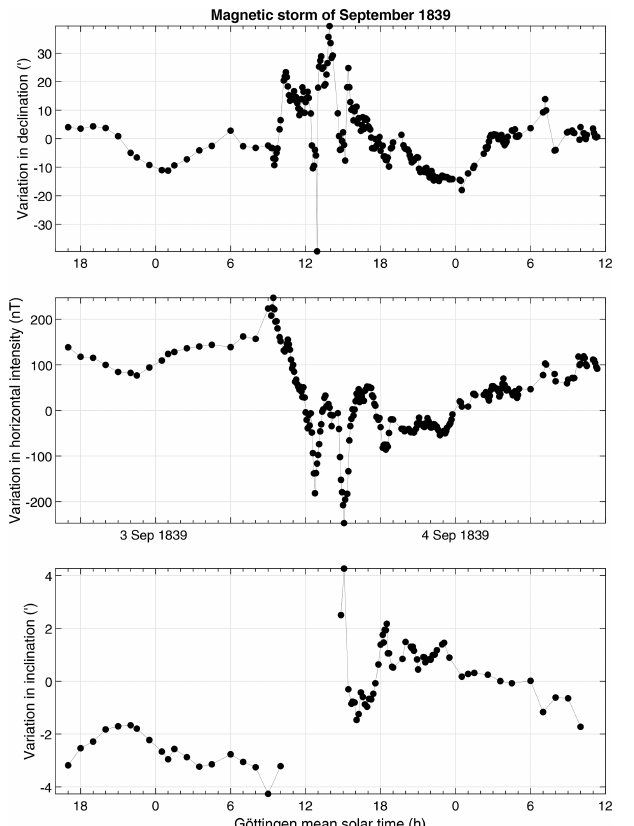
Figure 4. The first magnetic storm recorded at the Clementinum observatory in Prague on 3–4 September 1839 (Hejda et al., 2021a, b). The course of magnetic declination, horizontal intensity and magnetic inclination is shown. For the records of declination and inclination, conversion from divisions of the instrument scale obtained from the yearbook (Kreil, 1842) to angular units was per- formed. Despite the visible gap in the inclination record, it is indi- cated here that a slight change in inclination during the main phase of a magnetic storm was feasible at that